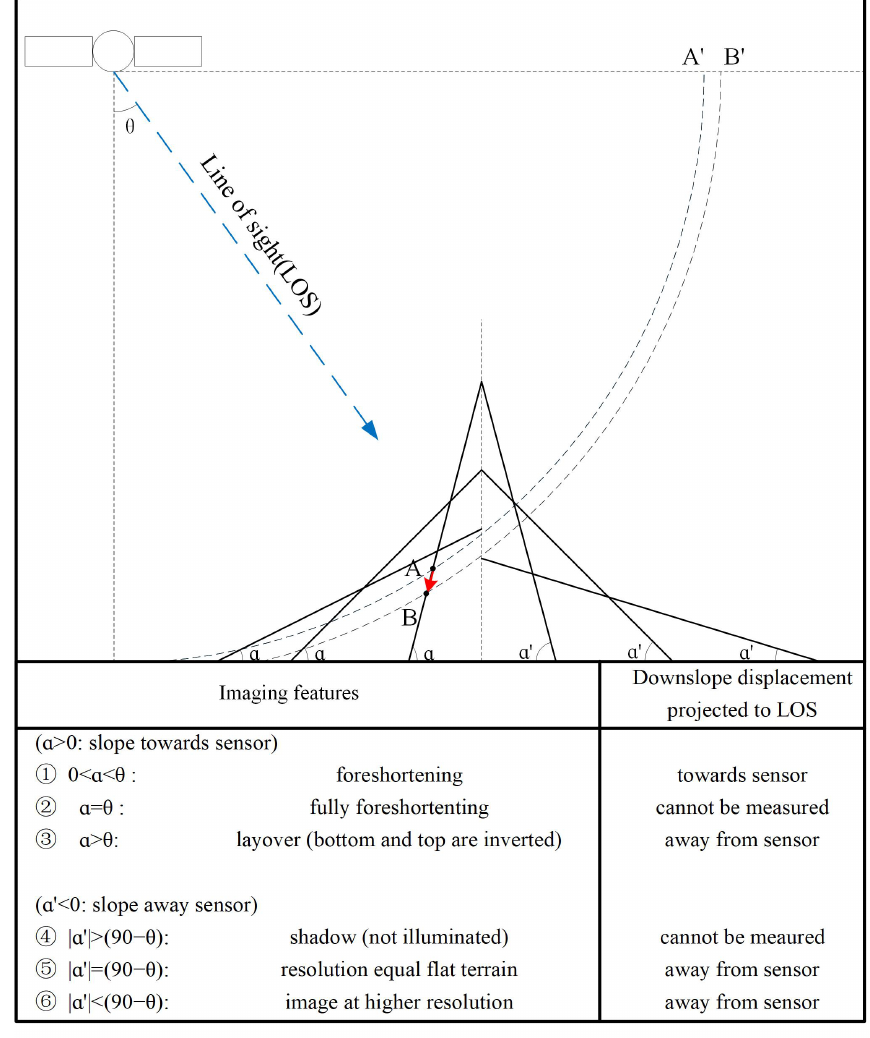
Figure 6. Relationships between the LOS and the downslope displacements for different slope orientations (scenarios 1, 2 and 3 are facing the sensor, and scenarios 4, 5 and 6 are facing away from the sensor) and slopes ( α and α ’).